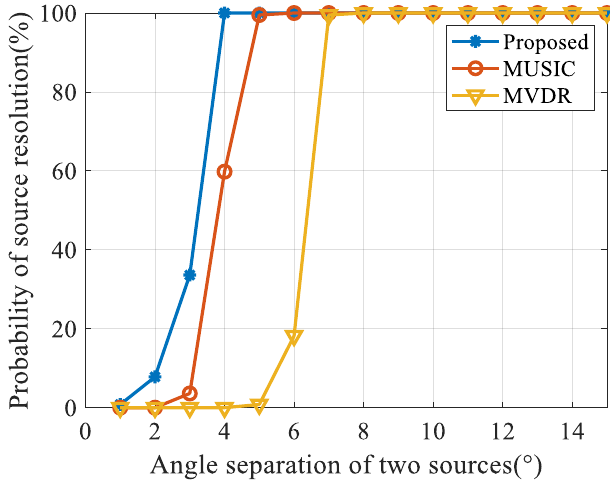
Figure 9. Results of the probability of source resolution versus angle separation.